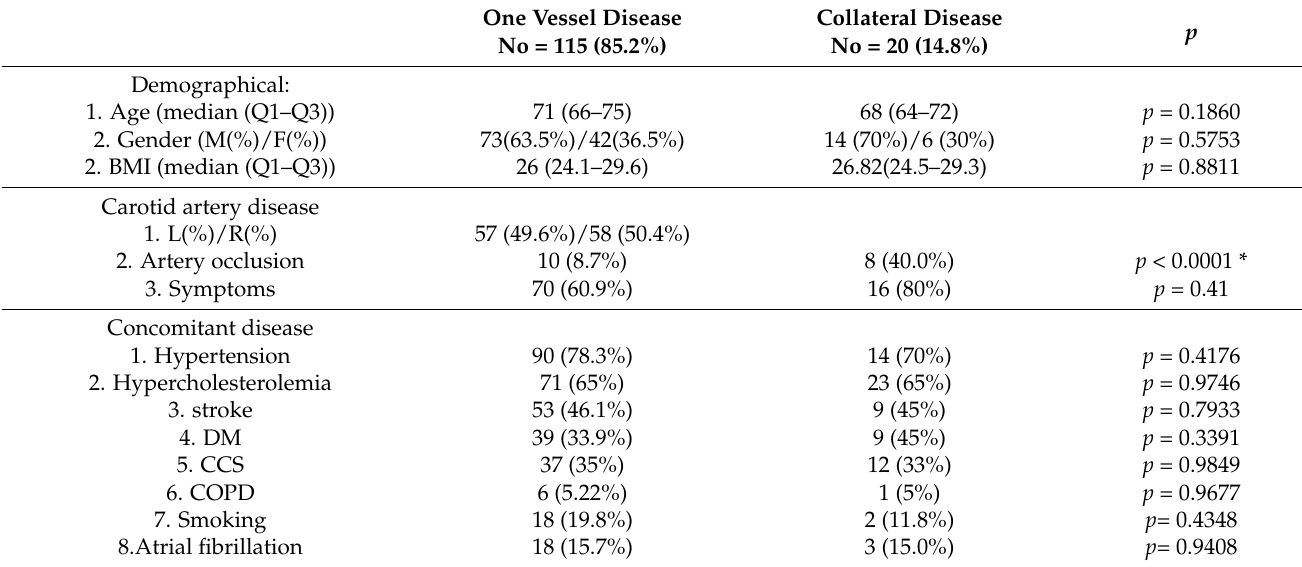
Table 1. Demographical and clinical